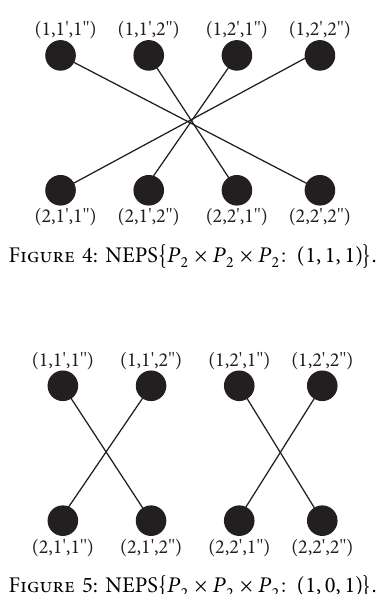
× P × P : ( 1 , 0 , 1 ) 􏼈 􏼉 2 2 2